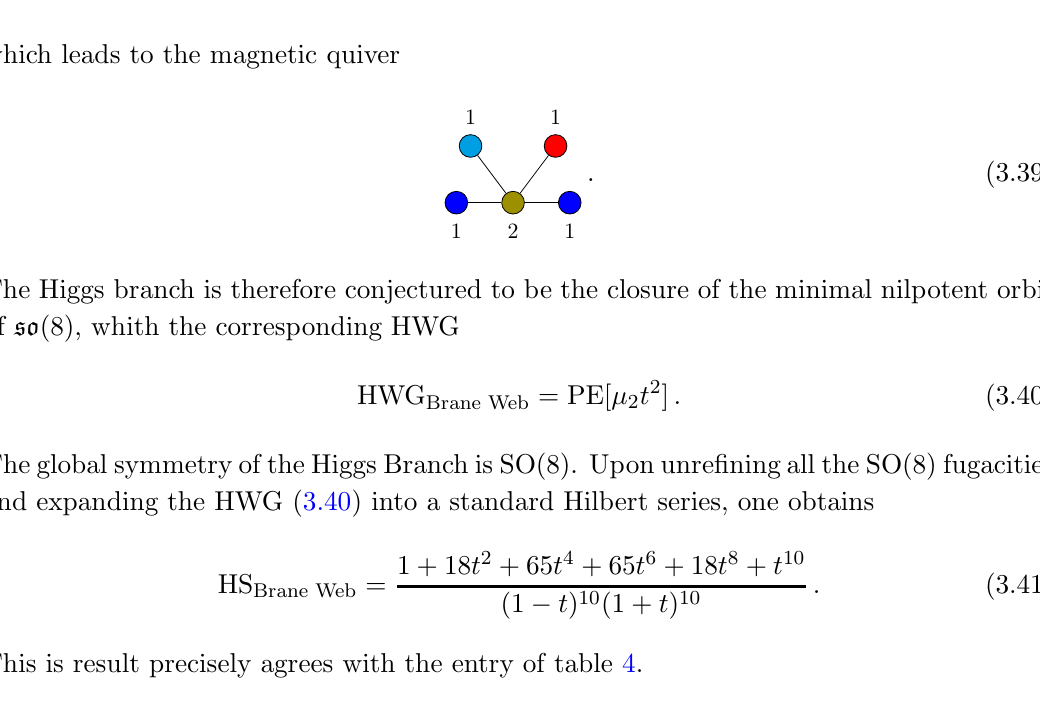
Table 6 . Schematic representation of the magnetic quivers for SU( N c ) SQCD with 8 supercharges obtained from five-brane webs. The drawing in a given square suggests the shape of the magnetic quiver. The actual magnetic quivers can be found in figures